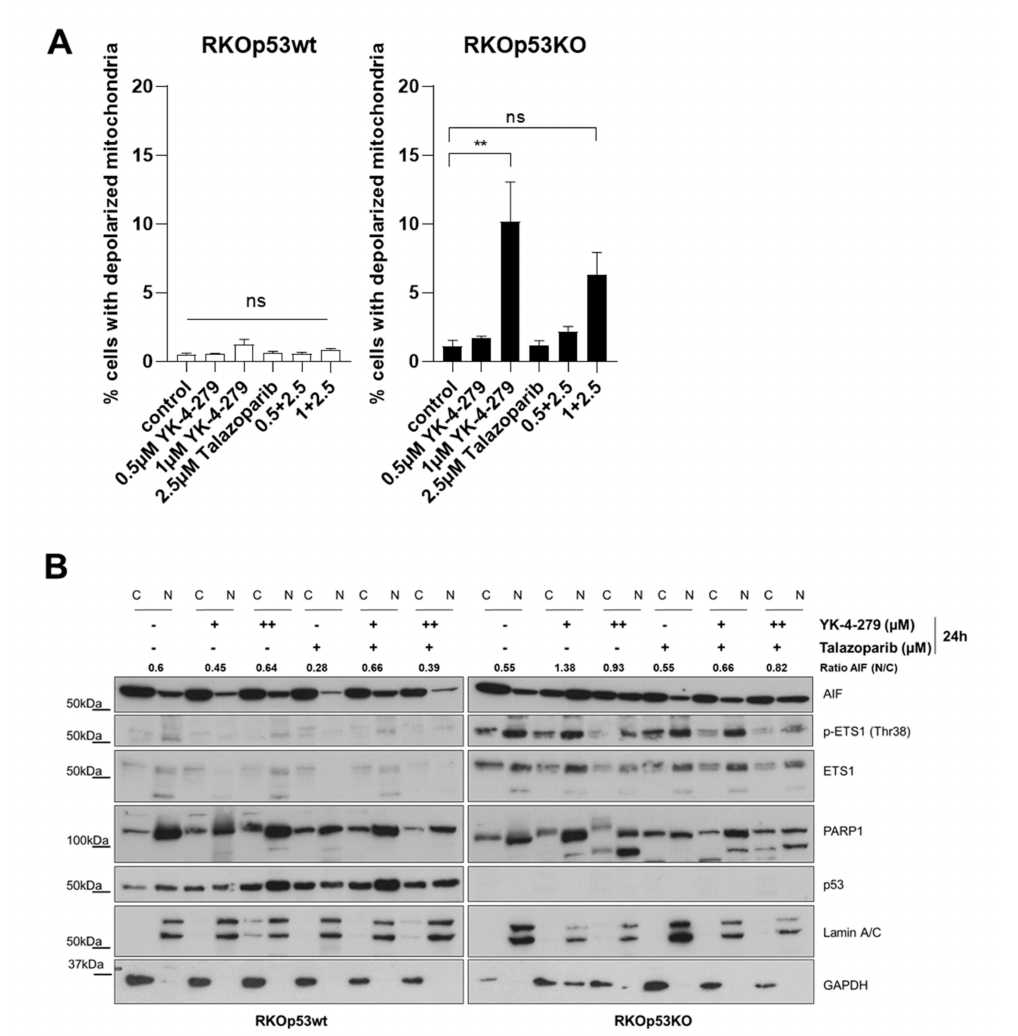
Figure 6. YK-4-279 induces parthanatos-like cell death. ( A ) Impact of YK-4-279 as indicated in absence or presence of talazoparib for 24 h on the mitochondrial membrane potential of RKOp53wt and RKOp53KO cells were analyzed with JC-1 staining followed by flow cytometry. Data are given as means ± standard error of mean (SEM) of three independent experiments. One-way ANOVA with Bonferroni post-test was performed to test for statistical significances. p values < 0.05 were considered significant, with ** p < 0.01. ns, not significant. ( B ) Changes in the amounts and subcellular localization of apoptosis-inducible factor (AIF), p-ETS1, ETS1, PARP1 and p53 were analyzed in nuclear (N) and cytoplasmic (C) fractions of RKOp53wt and RKOp53KO cells after exposure to YK-4-279 ( + , 0.5 µ M; ++ , 1 µ M) without or with talazoparib ( + , 2.5 µ M) for 24 h. Lamin A / C and GAPDH were used as purity control for nuclear extracts and cytoplasmic fractions, respectively. Densitometric quantification of nuclear versus cytoplasmic fractions of AIF is given as ratio of AIF (N / C)